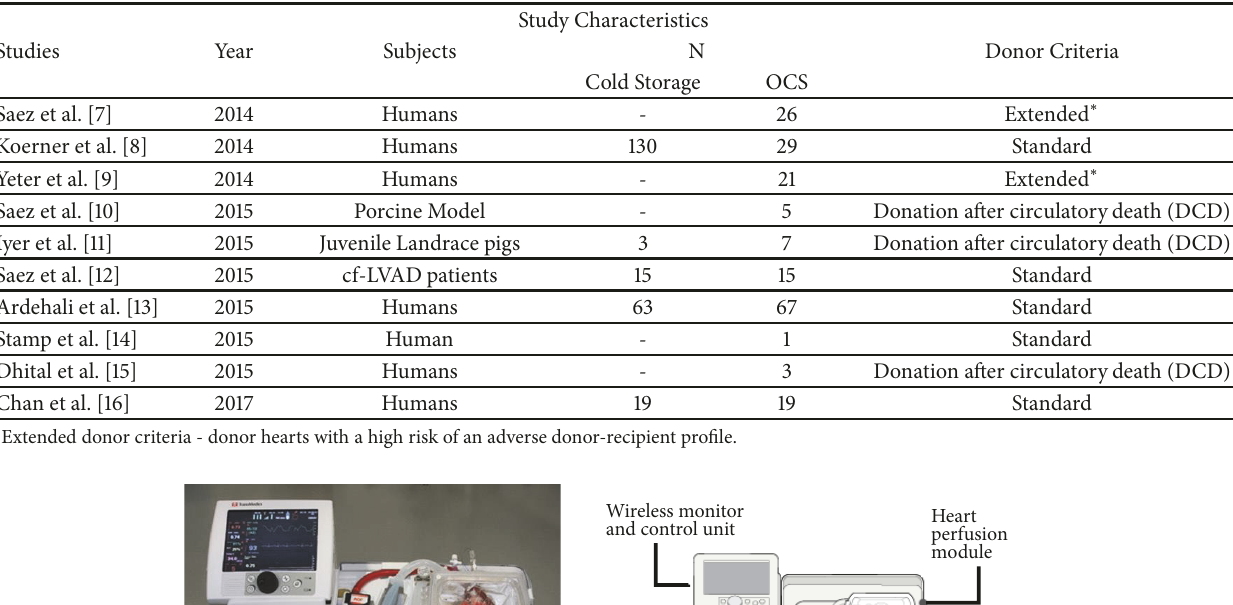
Table 1: Study Characteristics.